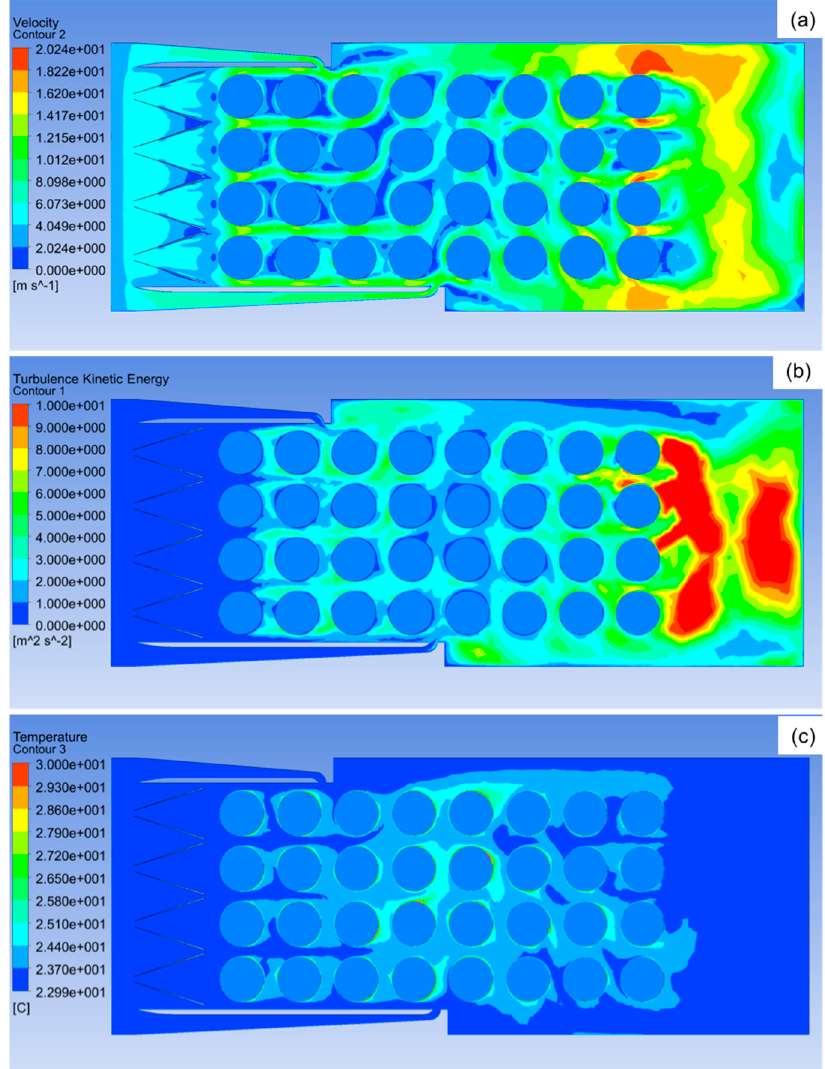
Figure 10. Contours of ( a ) velocity, ( b ) turbulence kinetic energy, and ( c ) temperature in the horizontal plane at 52 mm from the bottom of the battery pack for Case 4.